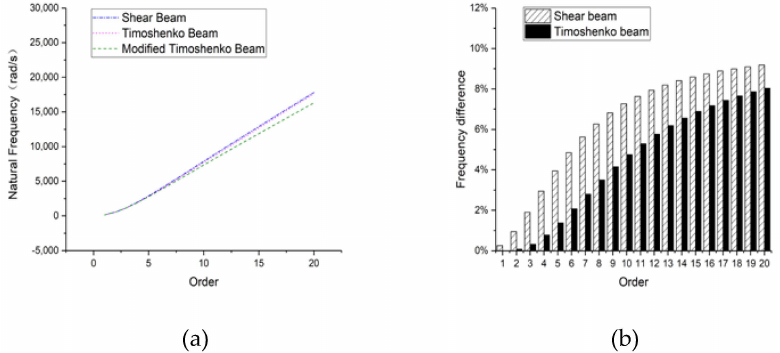
Figure 13. Natural frequencies of the 8-m-long beam: ( a ) overall frequency curve and ( b ) frequency di ff erence compared with a modified Timoshenko beam.